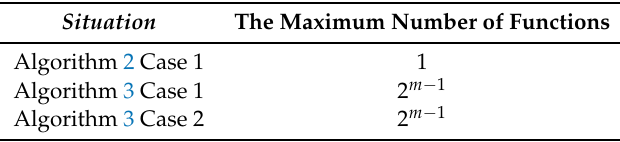
Table 1. Maximum number of functions per State